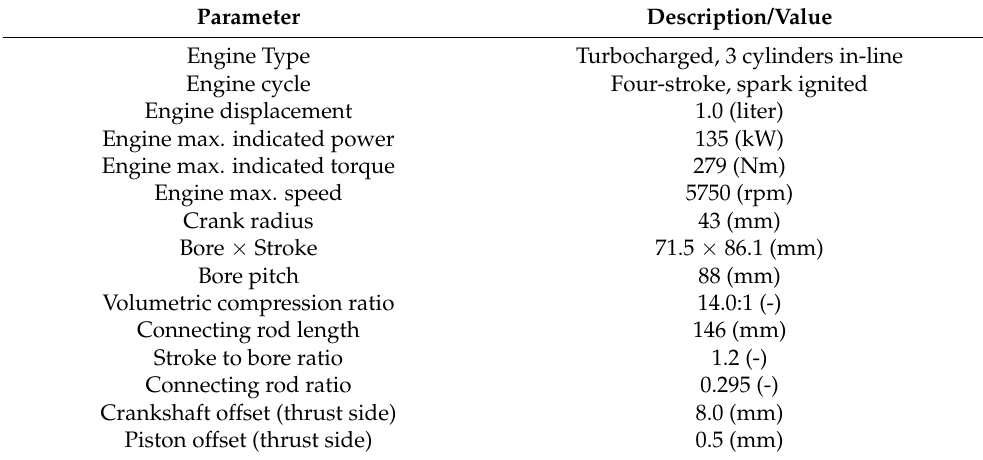
Table 4. Main engine specification. Parameter